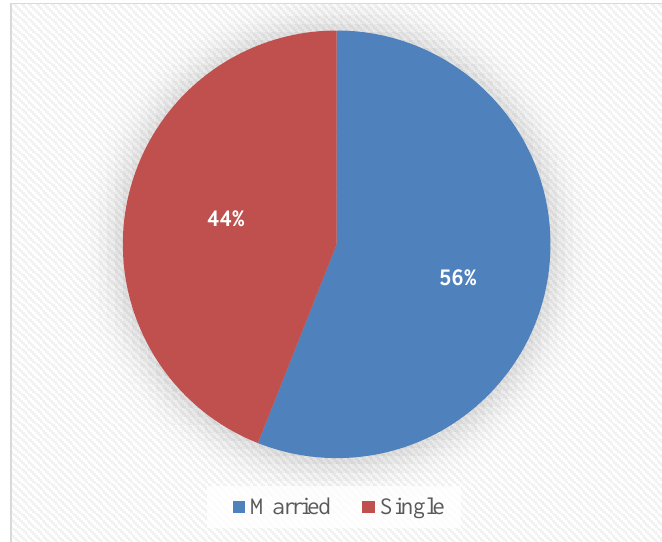
Figure 4. Statistical results for marital status